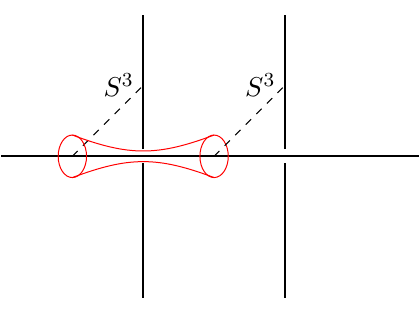
Figure 22 . Toric diagram for the conifold geometry.